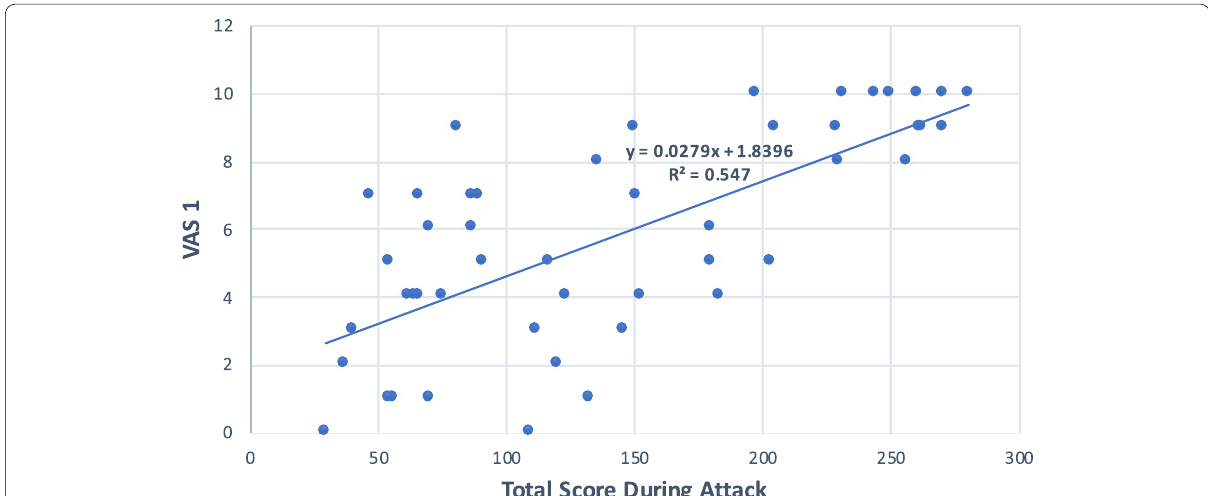
Fig. 2 Correlation between VADL scores and VAS scores during the attacks. VADL, Vestibular Disorder Activities of Daily Living Scale; VAS, Visual Analog Independence Scale